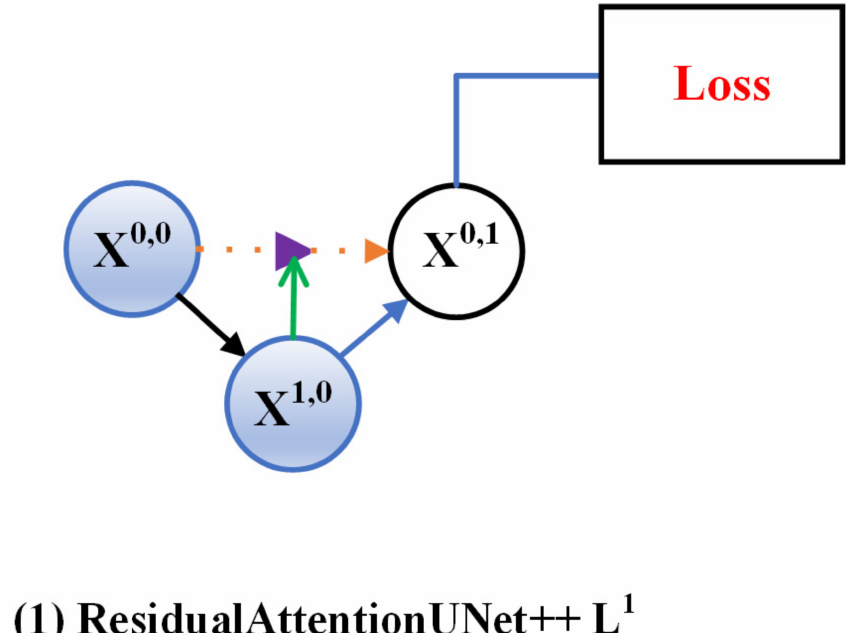
Figure 6. Residual-Attention UNet++ can be pruned to Residual-Attention UNet++ L 1 if trained with deep supervision.